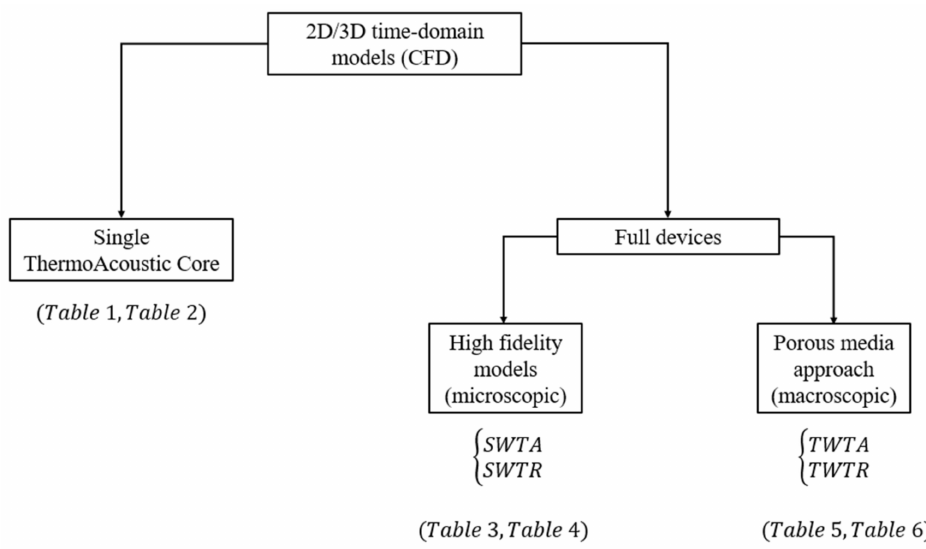
Figure 10. Criteria used to classify and analyze 2D/3D CFD